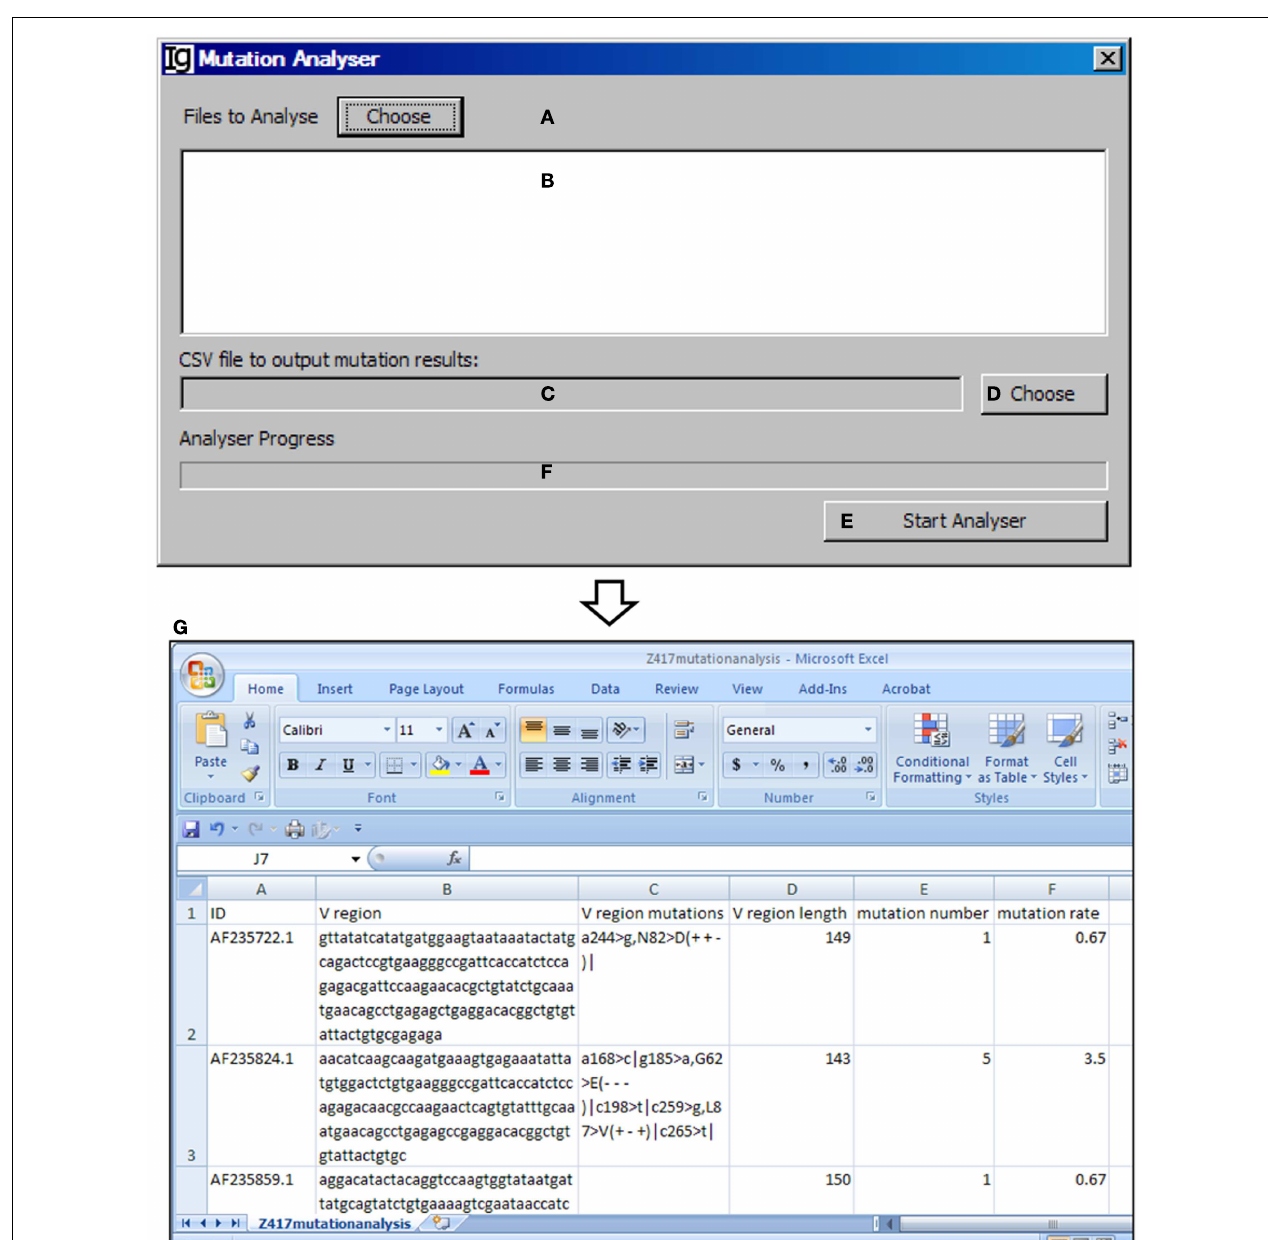
FIGURE 13 |The mutation analyzer . Diagram shows the interface of the Mutation Analyzer. (A) Button to choose the Excel file as downloaded from IMGT/V-QUEST. (B) Window area for displaying selected Excel files. (C) Textbox for displaying path of output mutation result file. (D) Button for selecting output file displayed in (C) . (E) Button to the start the analyzer. (F) Progress bar for showing the progress of analysis. (G) The mutation analysis results of the Z417 test sequences. Results show the sequence ID,V region, location of each mutation withinV region,V region length, mutation number, and mutation